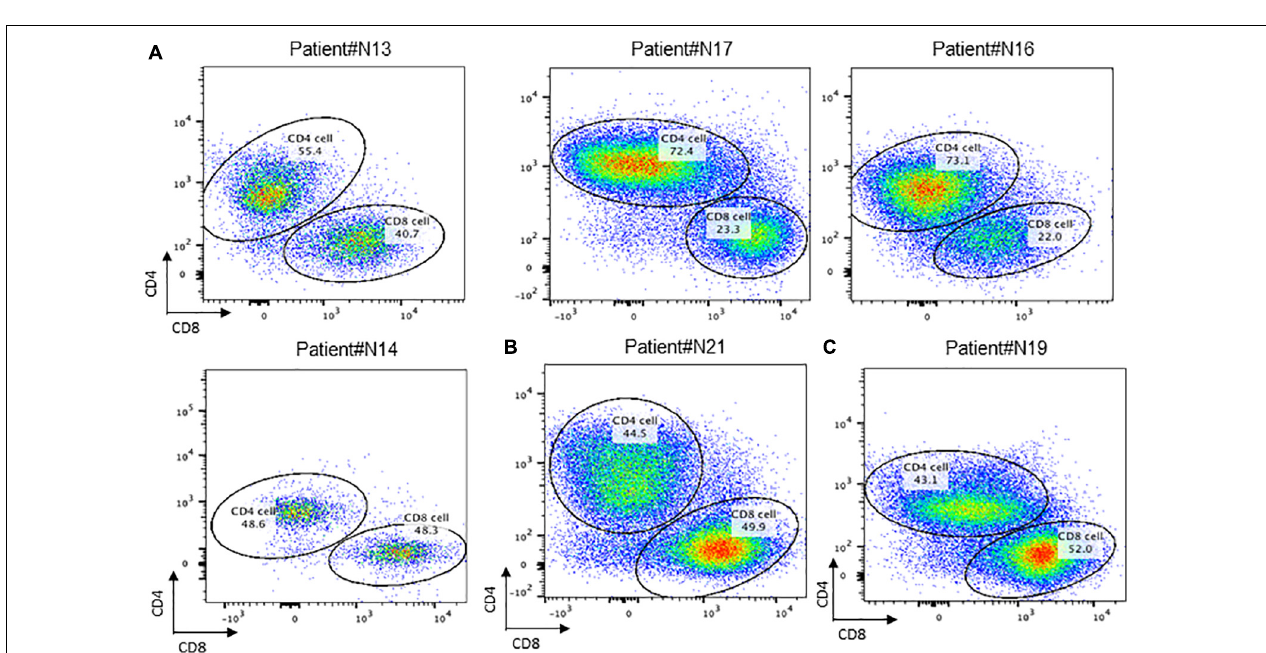
FIGURE 3 | Conception of CD4+ and CD8+ cells in NPC tissue. (A) Flow cytometry of CD4 + T cell and CD8 + T cell in recurrent NPC tissue; (B) Flow cytometry of CD4 + T cell and CD8 + T cell in primary NPC tissue. (C) Flow cytometry of CD4 + T cell and CD8 + T cell in residual NPC tissue.